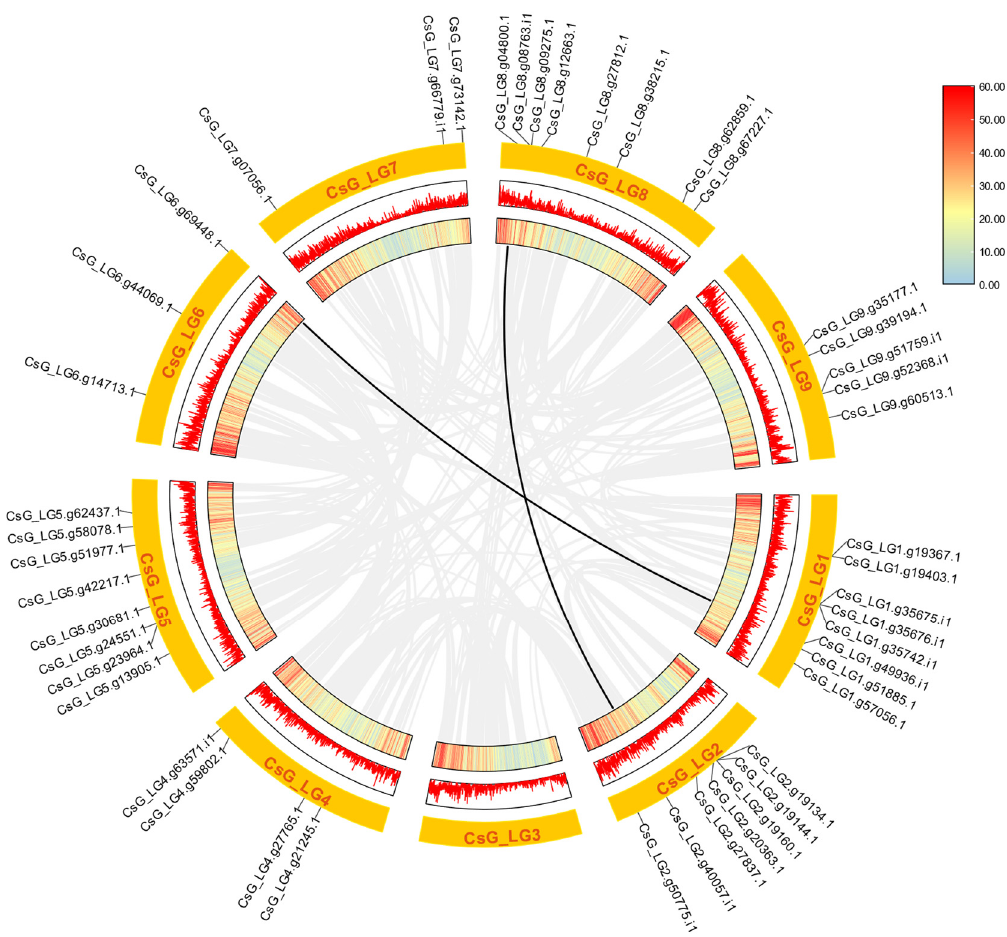
Figure 4. Genomic location and duplication pairs of the CsNF-Y gene on the chromosome of C. seticuspe . The yellow bands of CsG_LG1-9 represent nine chromosomes, respectively. Grey lines in the background represent collinear blocks of C. seticuspe ; black lines highlight syntenic CsNF-Y gene pairs.